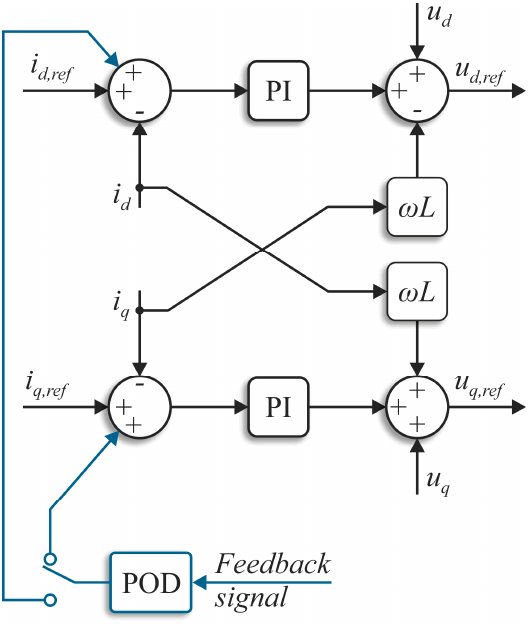
Figure 6. POD modulating the active or reactive current.